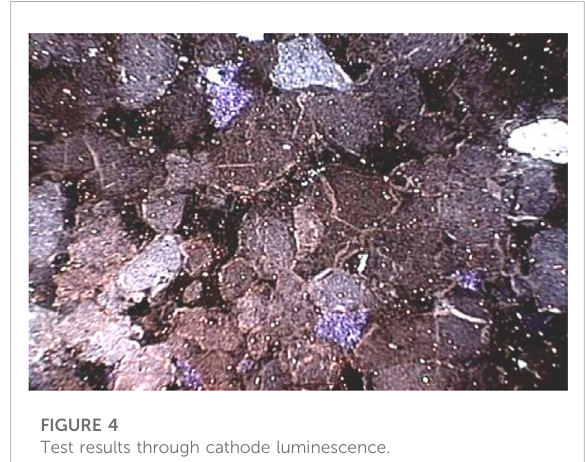
FIGURE 4 Test results through cathode luminescence.